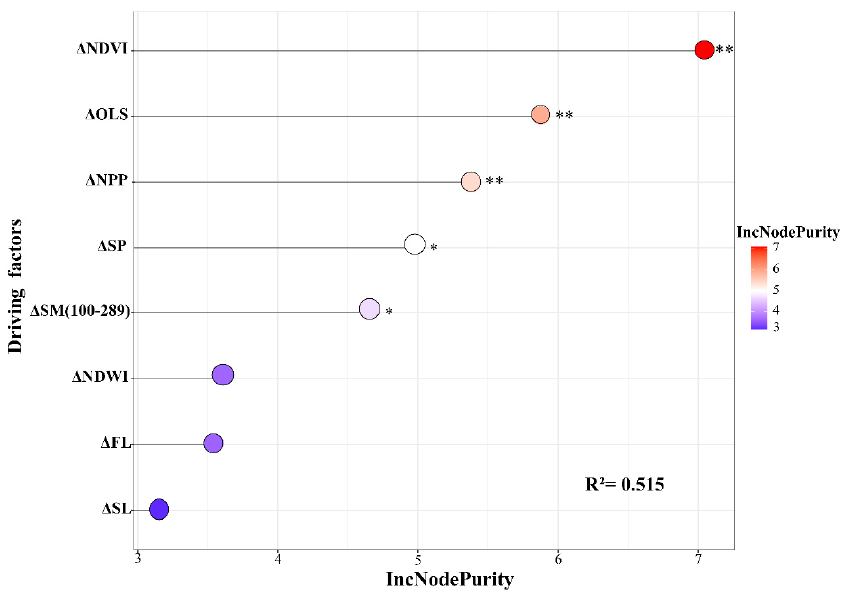
Figure 7. Ranking of the driving factors by importance according to the RFM results. The definitions of the abbreviated variables can be found in Table 1. The symbols ‘**’ and ‘*’ indicate that the factors are very significant ( p < 0.01) and significant ( p < 0.05), respectively. The RFM is the random forest model.